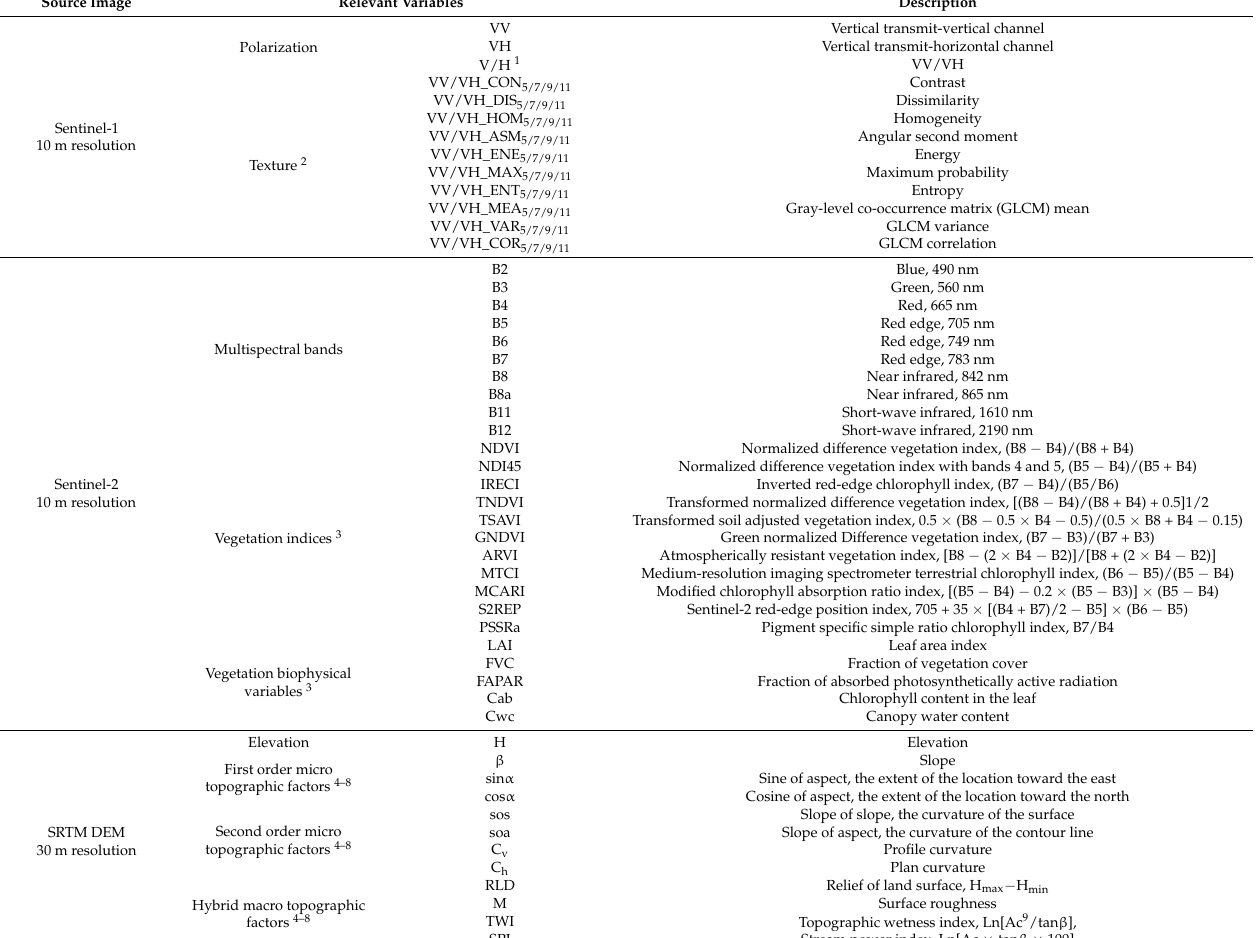
Table 1. Remote sensing indices from the Sentinel series and SRTM digital elevation model (DEM) data for AGB